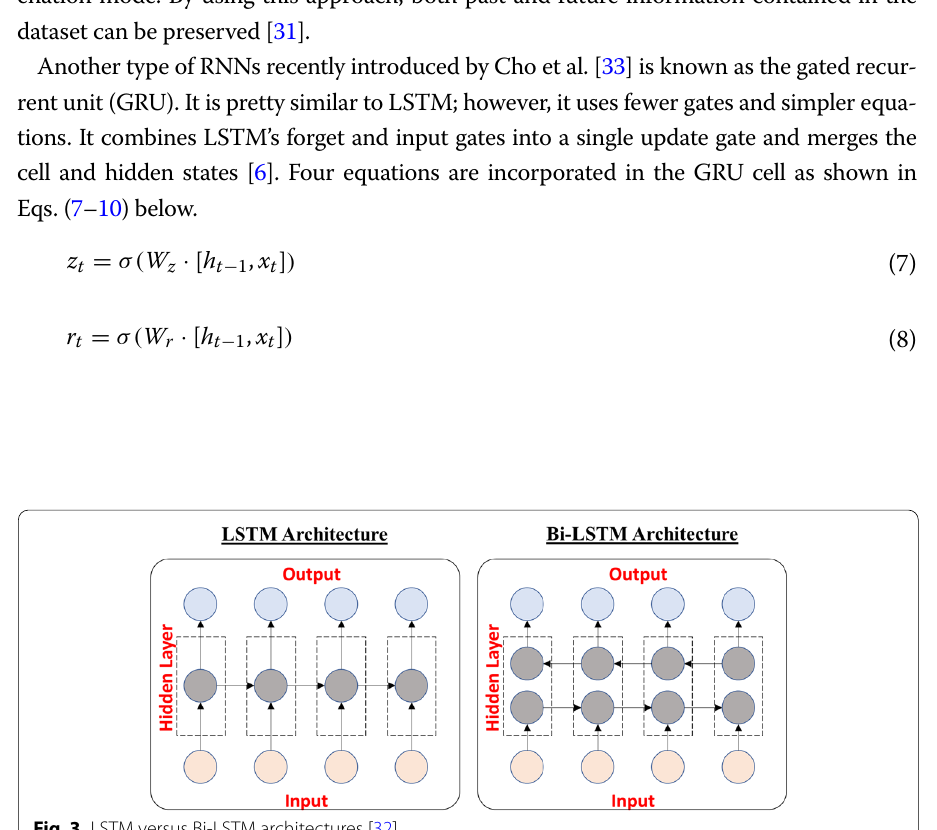
Fig. 3 LSTM versus Bi-LSTM architectures